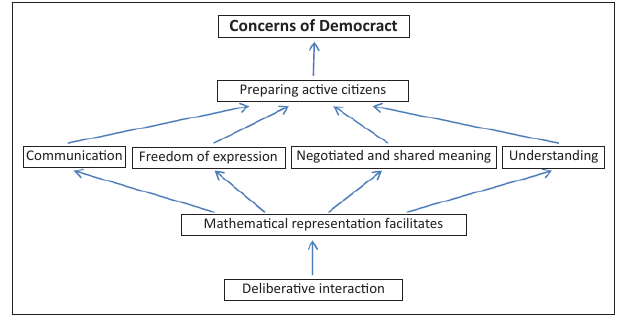
FIGURE 2: Various mathematical representations supporting deliberative interaction in the context of